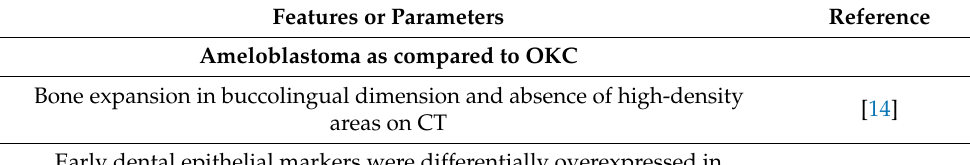
Table 1. Relevant features or parameters that might differentiate or distinguish radiographically resembling